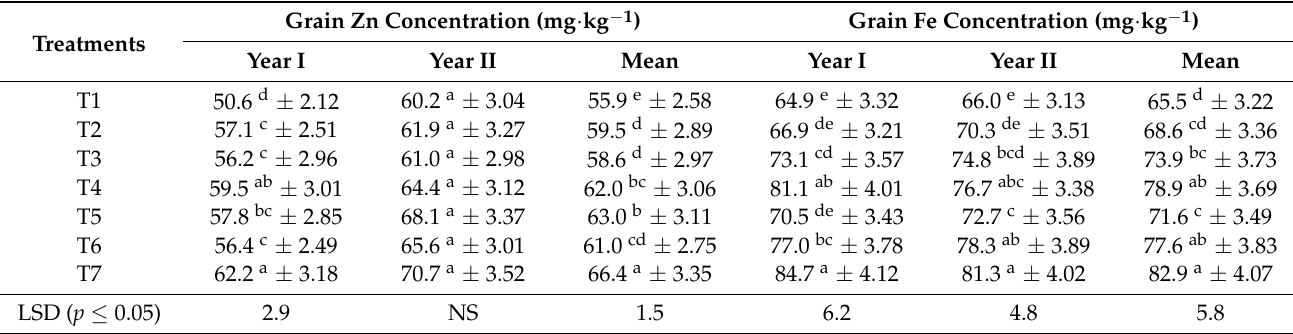
Table 3. Effect of biofortification on Zn and Fe concentration in the grain of lentil. Treatments